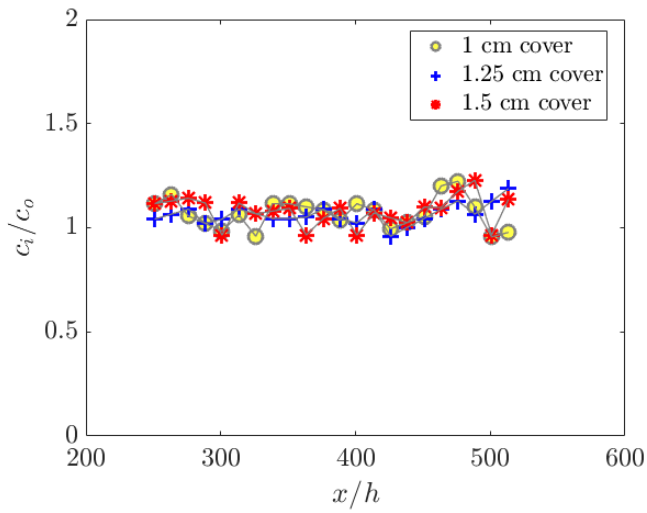
Figure 12. Phase speed of waves traveling through viscoelastic covers with different scales. Results are found by using the present computational model.